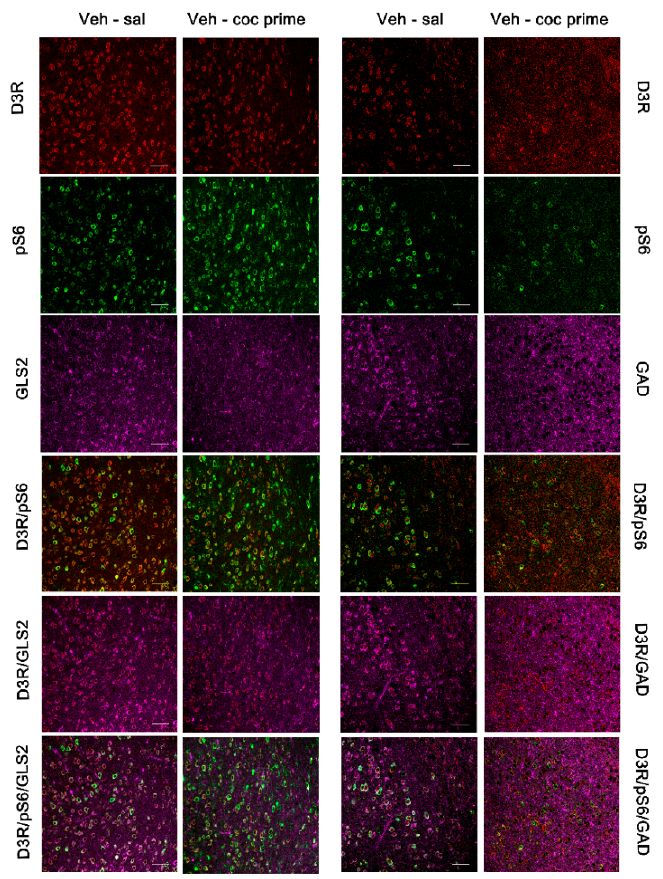
Figure 6. Representative confocal images showing the basolateral amygdala coronal sections im- munostained for dopamine type 3 receptor (D3DR, red), phosphorylated S6 protein (activated; green), GLS2 (magenta, glutamatergic neurons), and GAD (magenta, GABAergic neurons) from controls (veh-sal) and from mice receiving a cocaine-prime dose after 60 days of abstinence (veh-coc prime). Colocalization of D3DR/GLS2, pS6/GLS2, DRD3/pS6/GLS2, D3DR/GAD, pS6/GAD, and DRD3/pS6/GAD are also shown in the figure. Scale bars: 50 µ